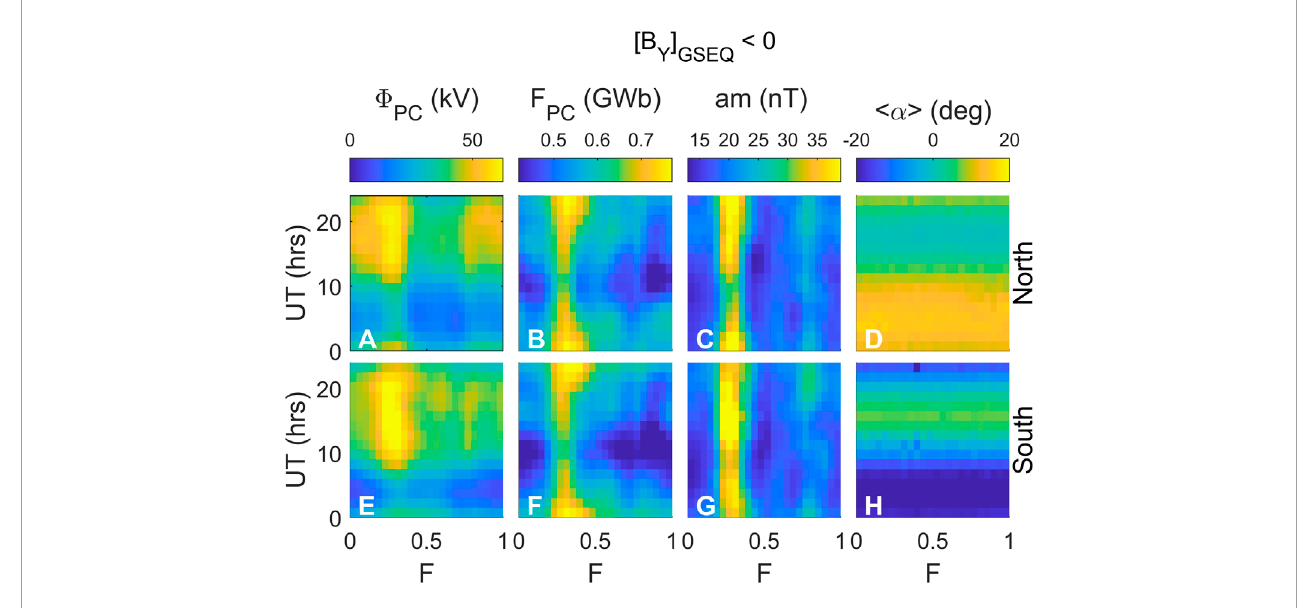
FIGURE 13 Same as Figure 12 for negative mean IMF [ B Y ] GSEQ .